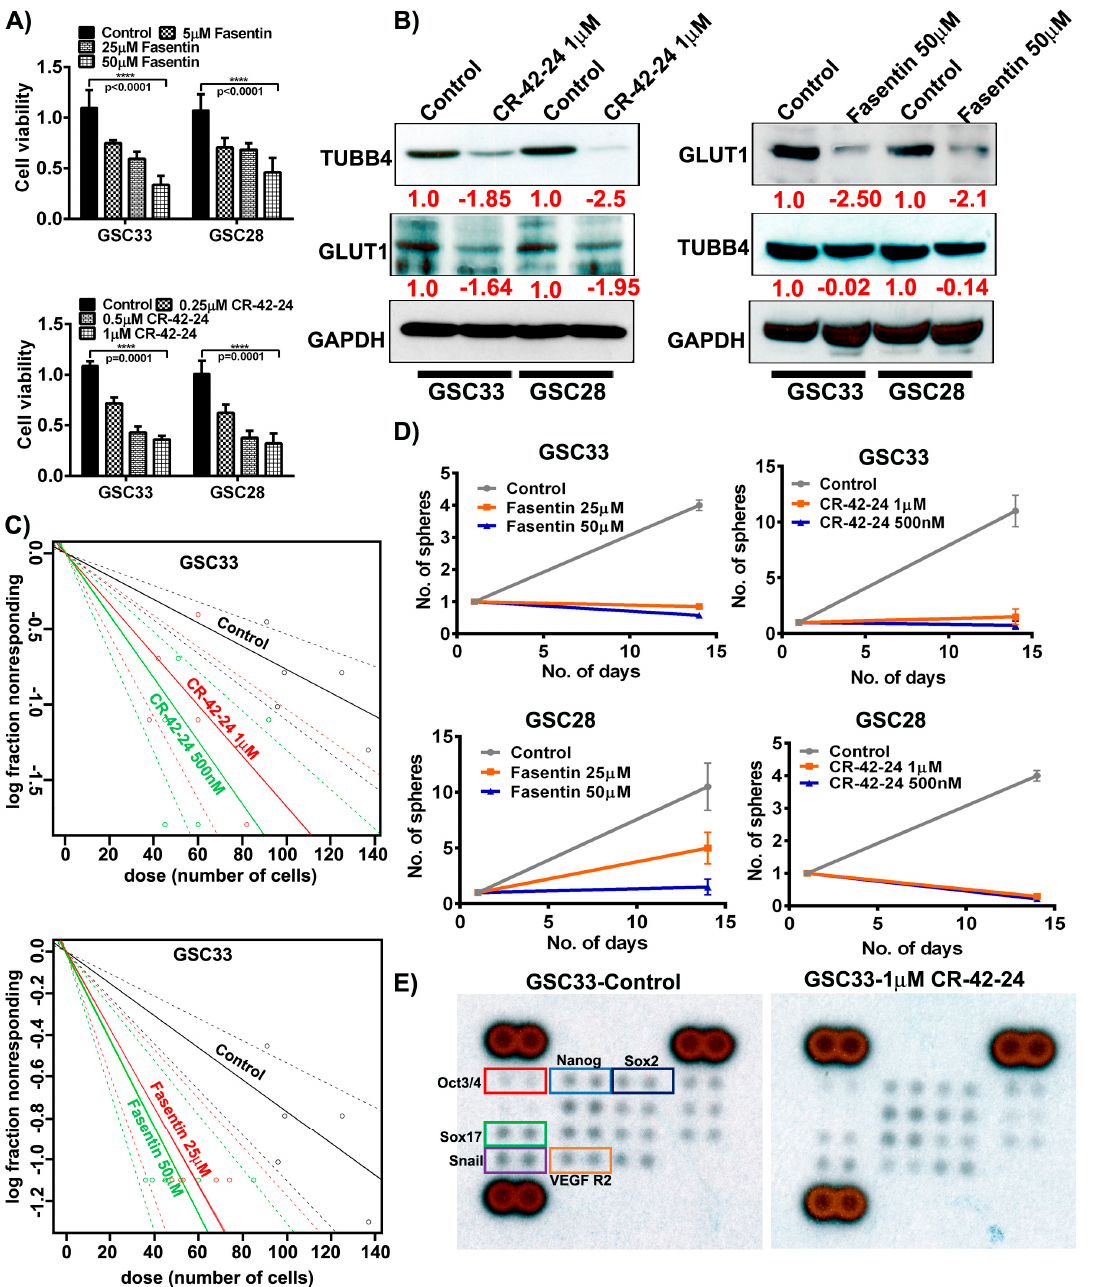
Figure 5. Targeting GLUT1 and TUBB4 reduces GSC cell growth and proliferation. ( A ) MTT analysis of increasing concentration of fasentin and CR-42-24 on GSC33 and GSC28. ( B ) Immunoblot analysis of GLUT1 and TUBB4 in GSC33 and GSC28 cells treated with 1 µ M CR-42-24 and 50 µ M fasentin. GAPDH was used as a loading control. ( C ) Limiting dilution assays were performed on GSC33 cells treated with fasentin and CR-42-24 with increasing concentrations and increased number of cells. ( D ) Tumorsphere formation assay in GSC33 and GSC28 cells. ( E ) GSC33 cells treated with 1 µ M CR-42-24 showed reduced levels of various stem cell factors when compared to the untreated cells. A human pluripotent stem cell antibody array (ARY010) was used in this study.